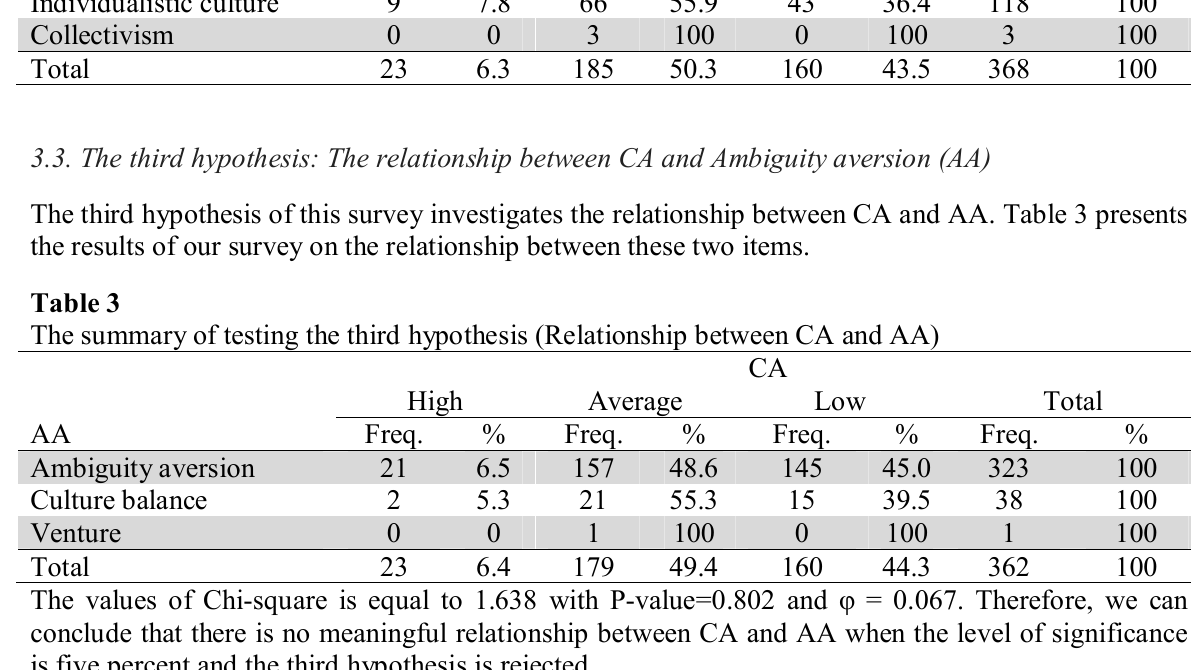
High Average Low Total